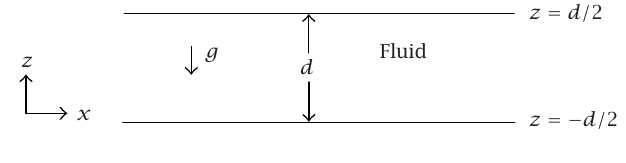
Figure 2.1 . Benard